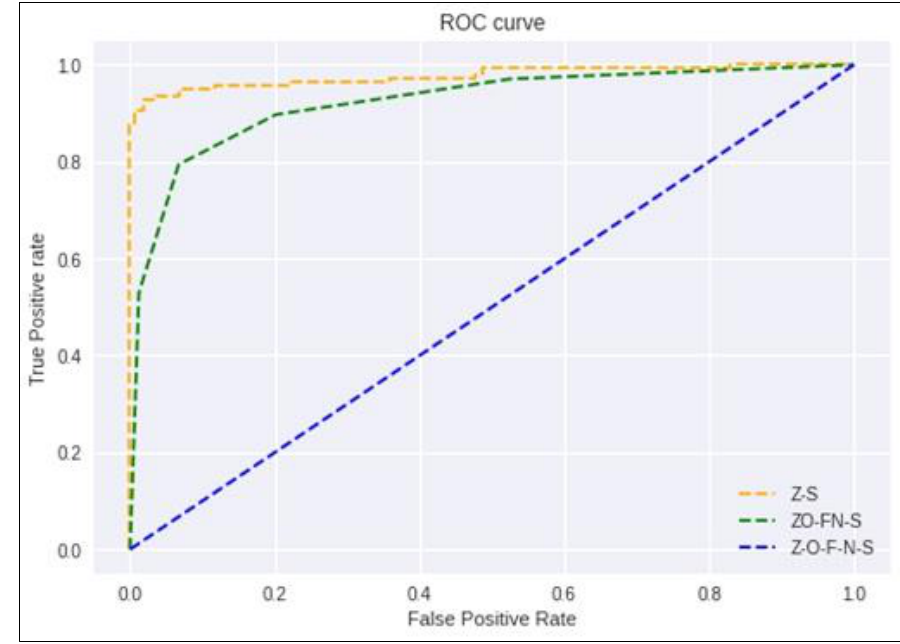
Figure 3. AUC Curve of three classes